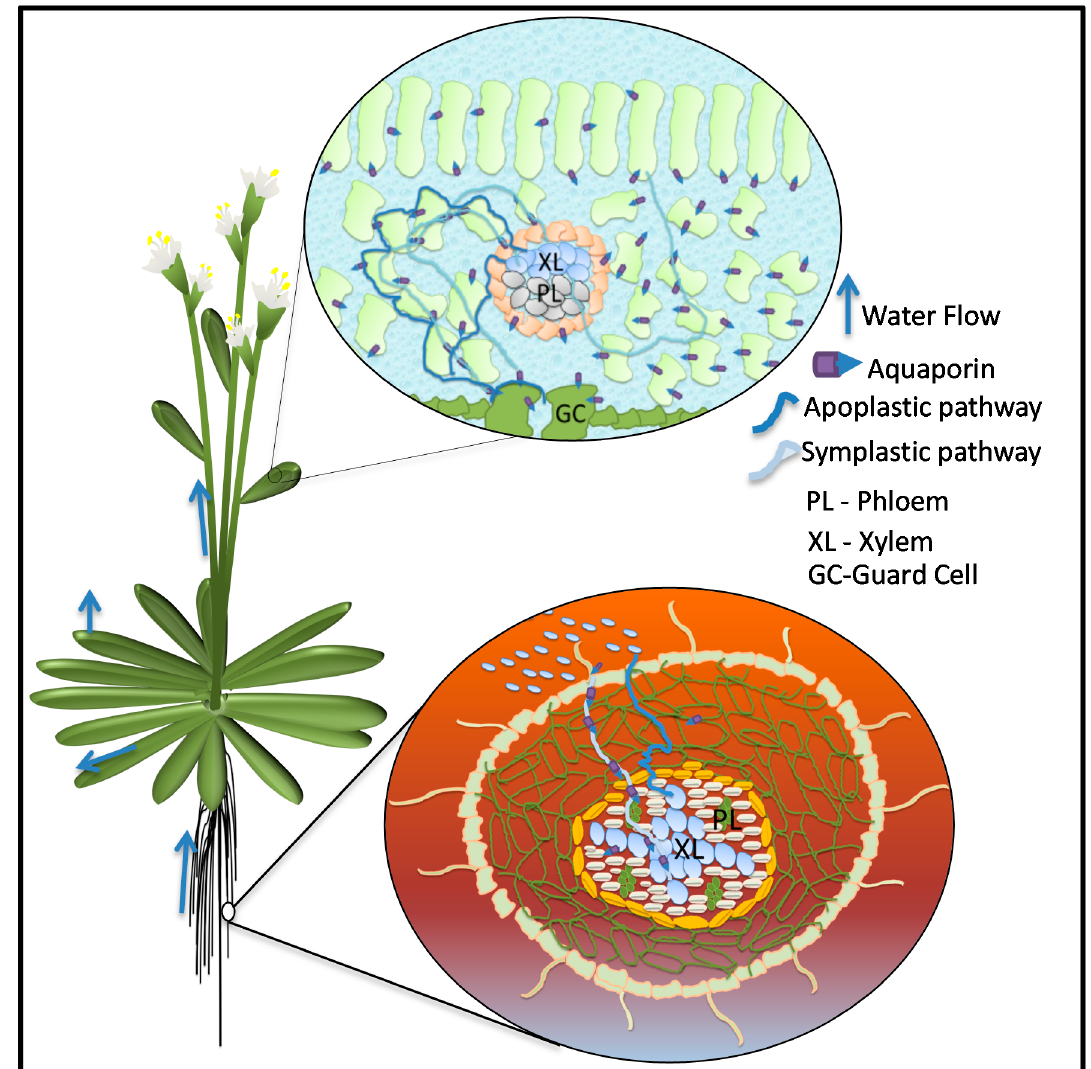
Figure 2. Water flow in plant from roots to aerial parts. Leaf cross-section shows flow of water through apoplastic and symplastic water pathways. In apoplastic pathway, water flows across the cells through cell wall. In symplastic pathway, water moves through cytoplasm and cellular membranes. Aquaporins are involved in symplastic path facilitating transmembrane water flow across cells and subcellular compartments.